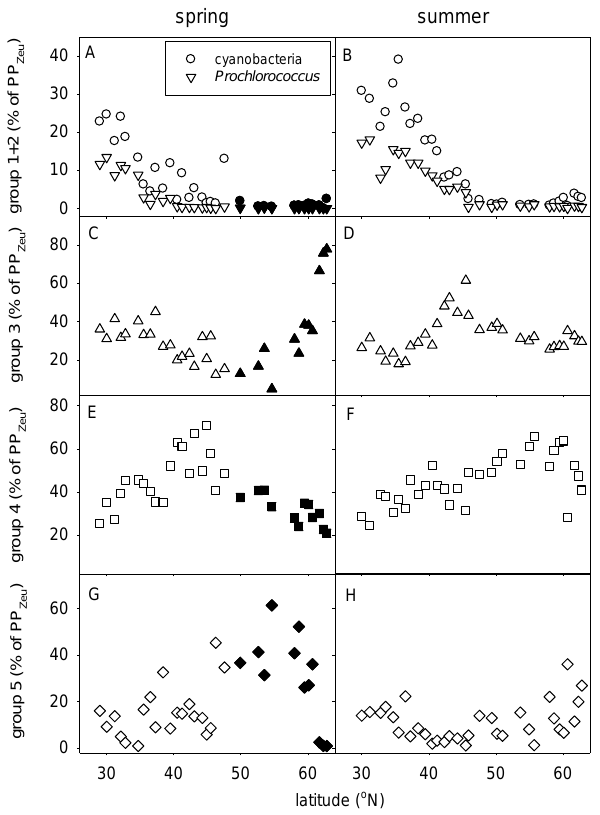
Fig. 8. Contributions to daily primary production in the euphotic zone of (A, B) group 1 ( Prochlorococcus ) and cyanobacteria (group 1+2); (C, D) group 3 (prasinophytes, cryptophytes, pelagophytes); (E, F) group 4 (haptophytes, dinophytes); (G, H) group 5 (diatoms) for the spring (A, C, E, G) and summer (B, D, F, H) and cruises. Black symbols represent data from non-stratified stations.